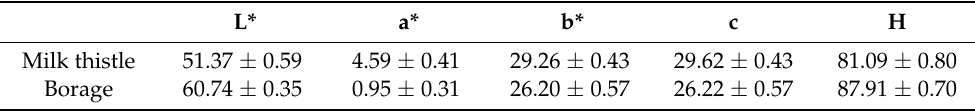
Table 6. Colour coordinates for milk thistle and borage oils.